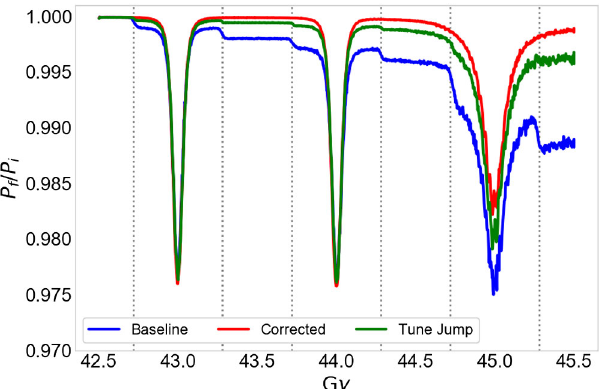
5. Polarization loss from Zgoubi tracking simulation in the uncorrected case (blue), the case corrected only via coupling resonance (red) and with only increase resonance crossing from the tune jump (green). Vertical dashed lines mark the locations of partial snake resonances. The excursions at integer values of G γ are due to spin